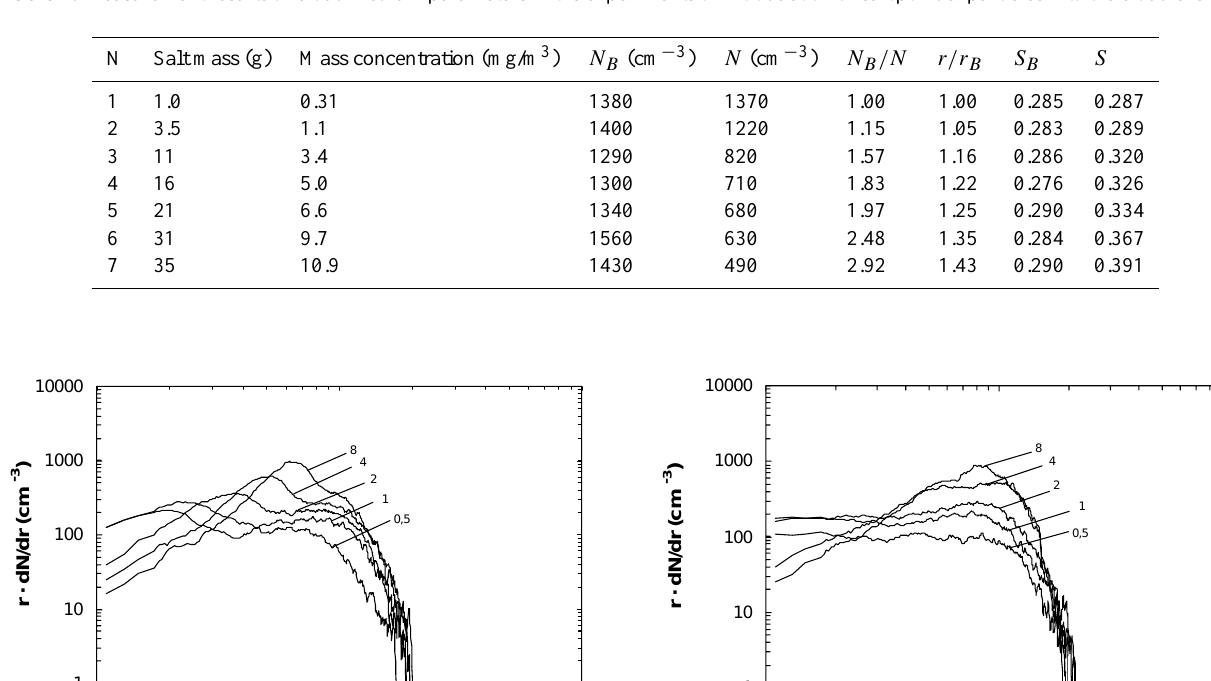
Table 1. Measurement results of cloud medium parameters in the experiments of introduction of salt powder particles into the cloud chamber.